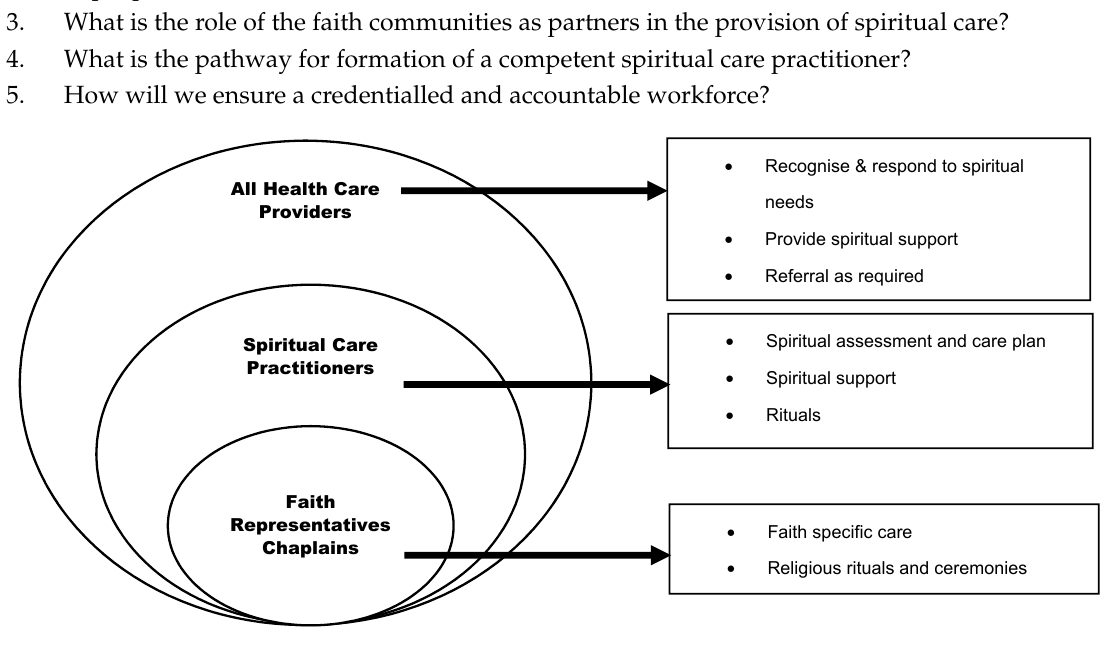
Figure 1. Model of Spiritual Care.